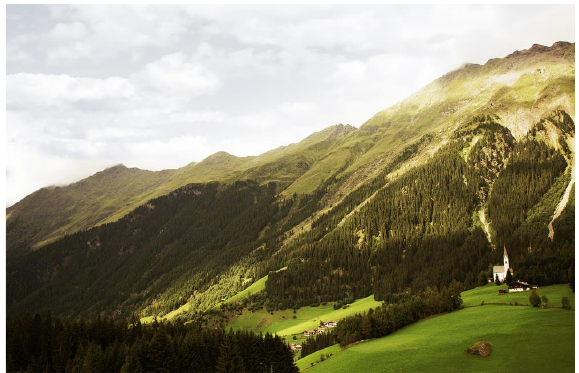
Figure 6. Typical timberline in an Alpine landscape. The transition from the forested region to grass land can be clearly seen in this picture, which is reproduced from a free download (https://unsplash.com/s/photos/timberline).